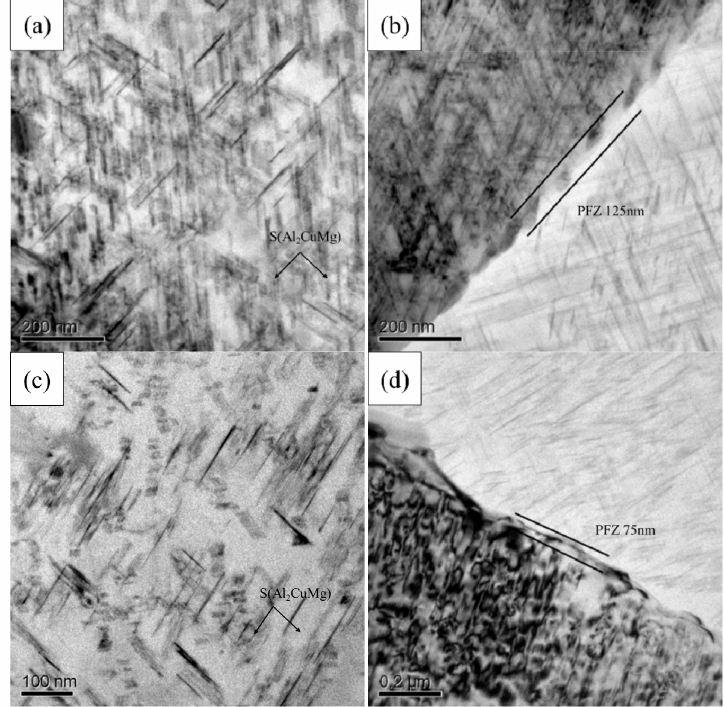
Figure 12. TEM micrographs of Al-Cu-Mg alloy under different stress levels after 12 h of creep aging at 180 ◦ C: ( a , b ) 0 MPa; ( c , d ) 210 MPa